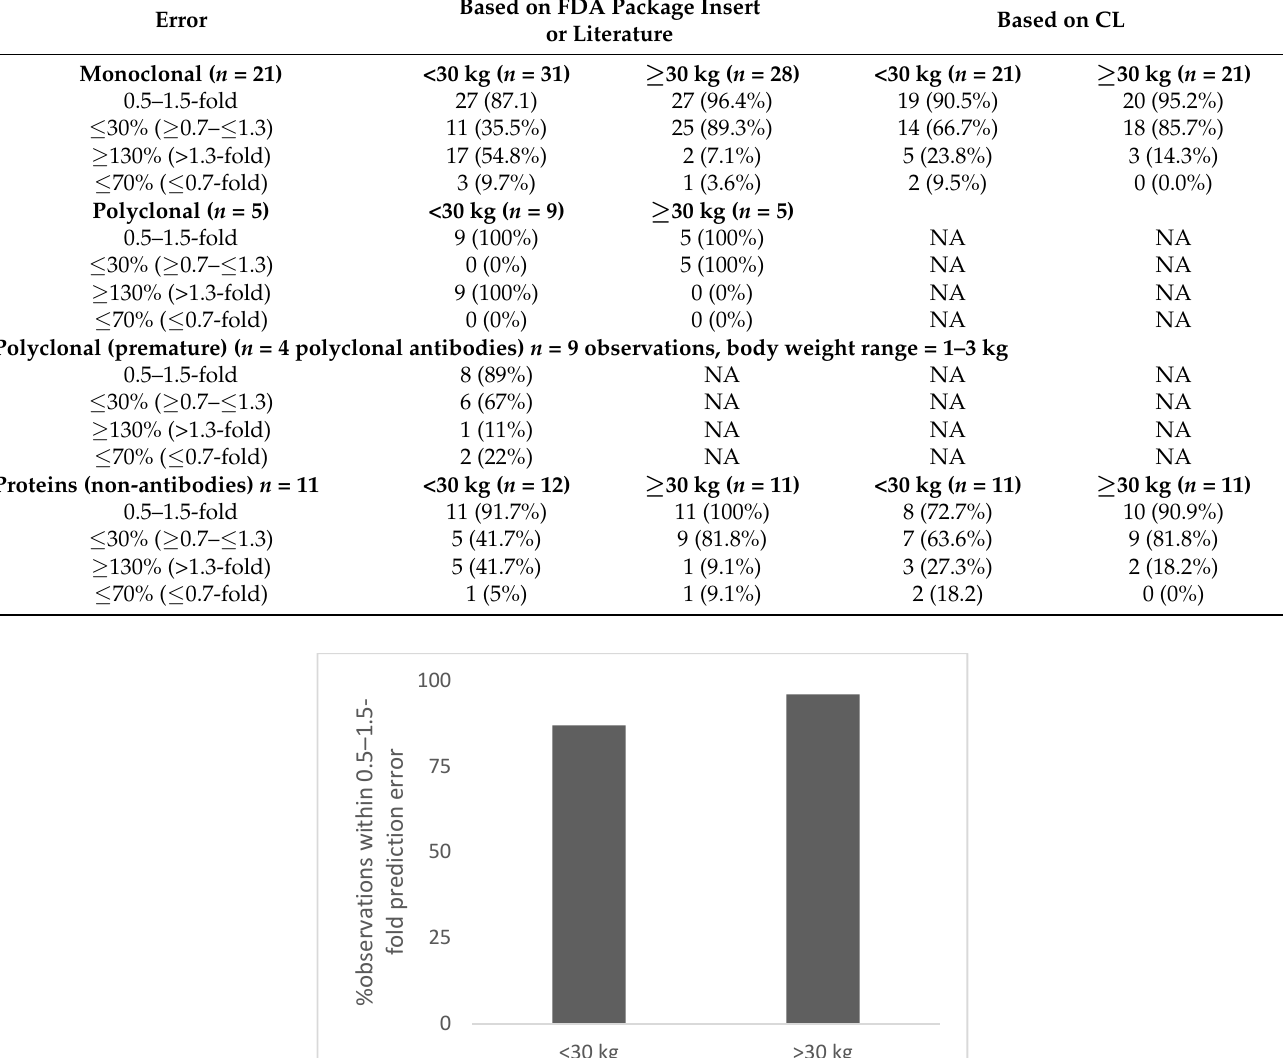
Table 1. Prediction of dose based on Salisbury Rule.